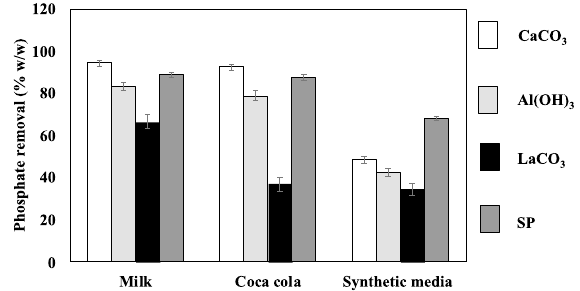
Figure 5. Comparison of spray-dried synbiotic formulation with commercial phosphate binders. Phosphate- rich foods that were used included milk, a soft drink, and synthetic media. Significant p -values ( p < 0.05 by two- tailed ANOVA, with n = 3 and alpha value of 0.95) were obtained and standard errors are shown as error